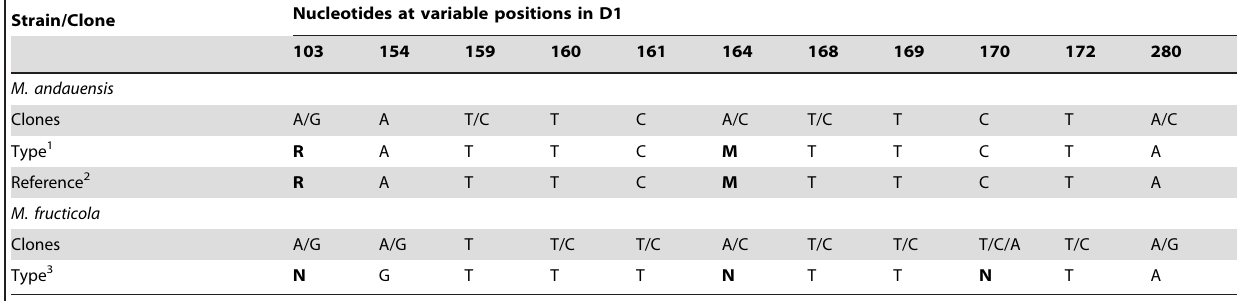
Strain/Clone Nucleotides at variable positions in D1